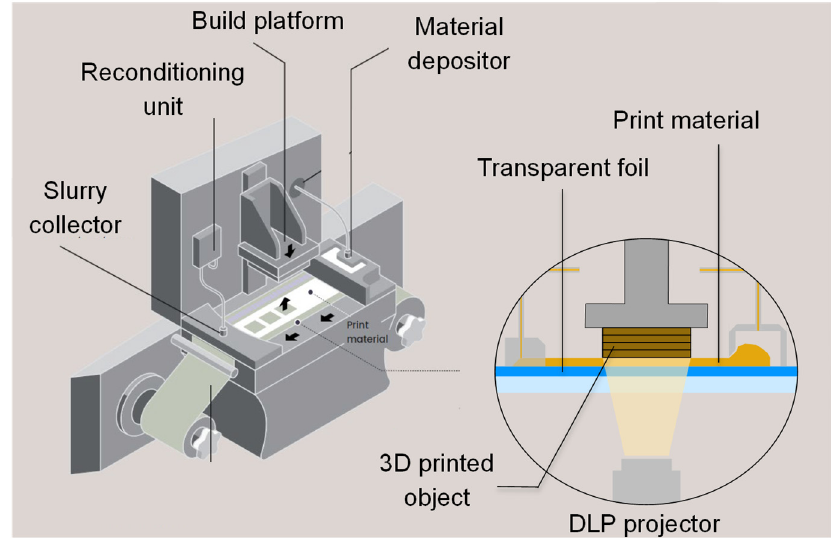
Figure 5. Schematic representation of the industrial ceramic 3D printer.